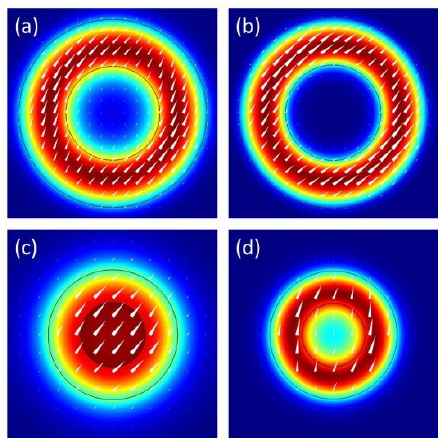
Fig. 1. Cross-sections of the electric field distribution of the fundamental guided mode (a),(b) in a 2 µm large capillary and (c),(d) in a 700 nm large capillary at (a),(c) 1064 nm and (b),(d) 532 nm wavelengths .